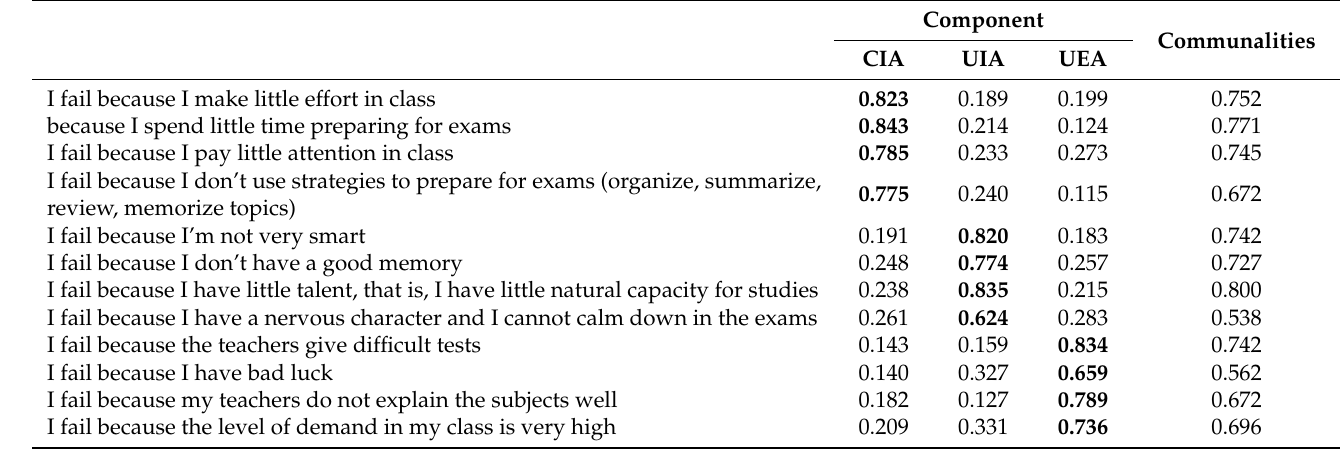
Table 2. Exploratory factor analysis of the “Academic Failure Attribution Scale”.